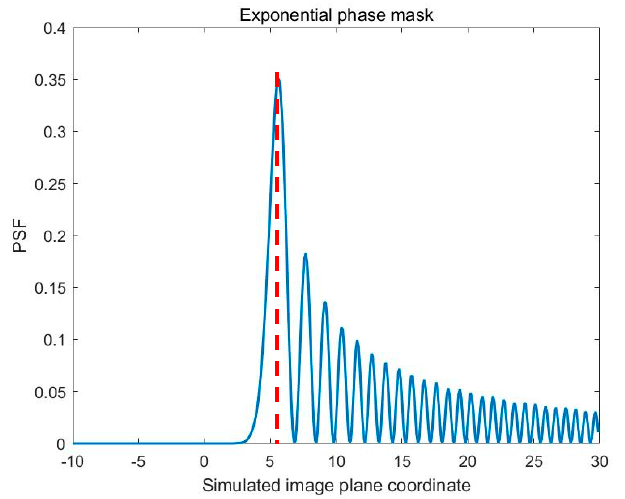
Figure 2. PSF in one − dimension of exponential phase mask.